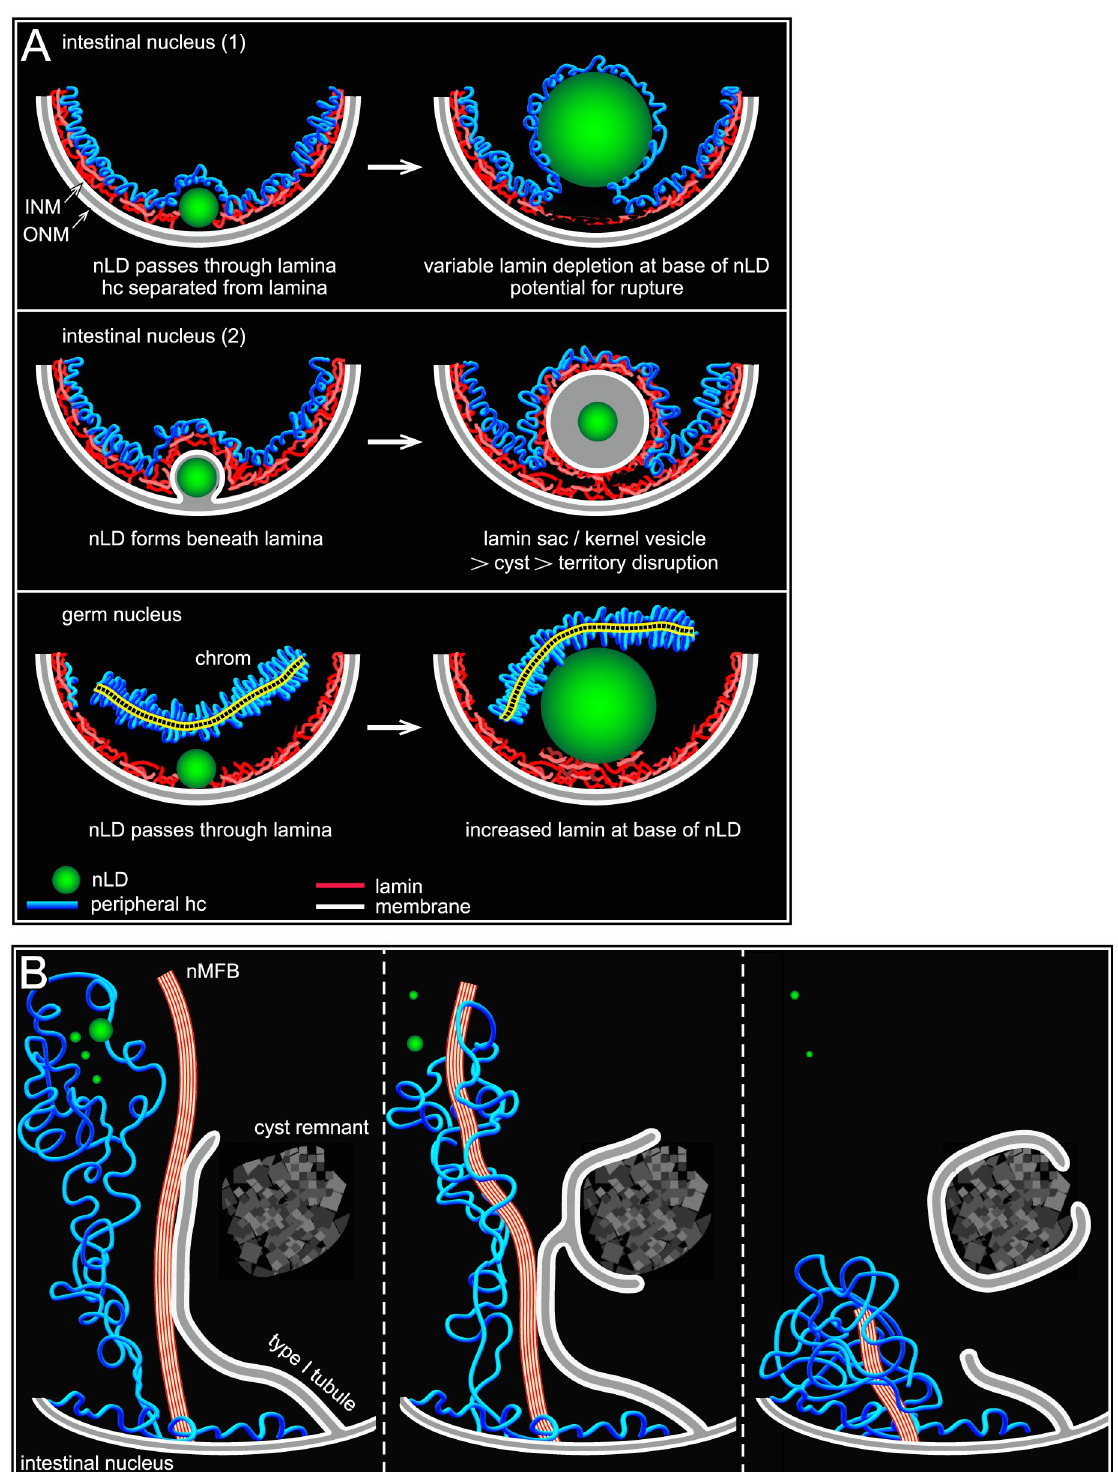
Fig 16. nLD-associated nuclear damage and repair. (A) Summary cartoon comparing damage-associated nLDs in intestinal nuclei with nLDs in germ nuclei, which do not appear to be deleterious. (B) Speculative model for repair of nLD-associated damage in intestinal nuclei. Lipolysis of a heterochromatin-coated nLD leaves inappropriate heterochromatin in the nuclear interior; nMFBs can bind to and return the heterochromatin to the periphery. nLDs contained in lamin sacs/kernel vesicles can form cysts and lyse, leaving debris and damaged